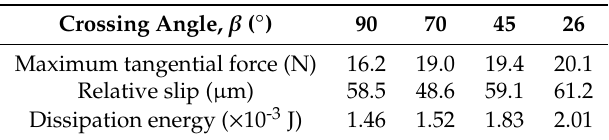
Table 6. Tangential forces and relative slips between steel wires during tension–torsion fretting fatigue and dissipation energies of tangential force versus displacement amplitude at fatigue cycles 20,000 at di ff erent crossing angles.